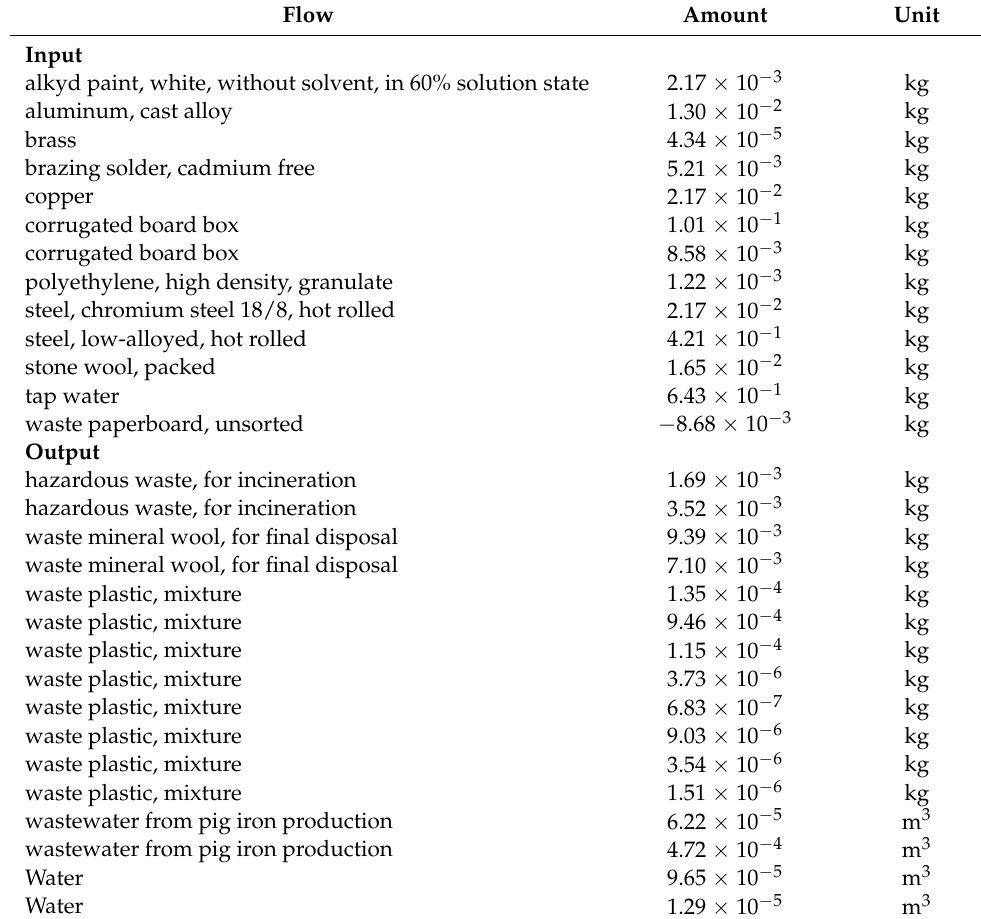
Table A5. Material inventory data for kerosene powered boiler (Case 3).